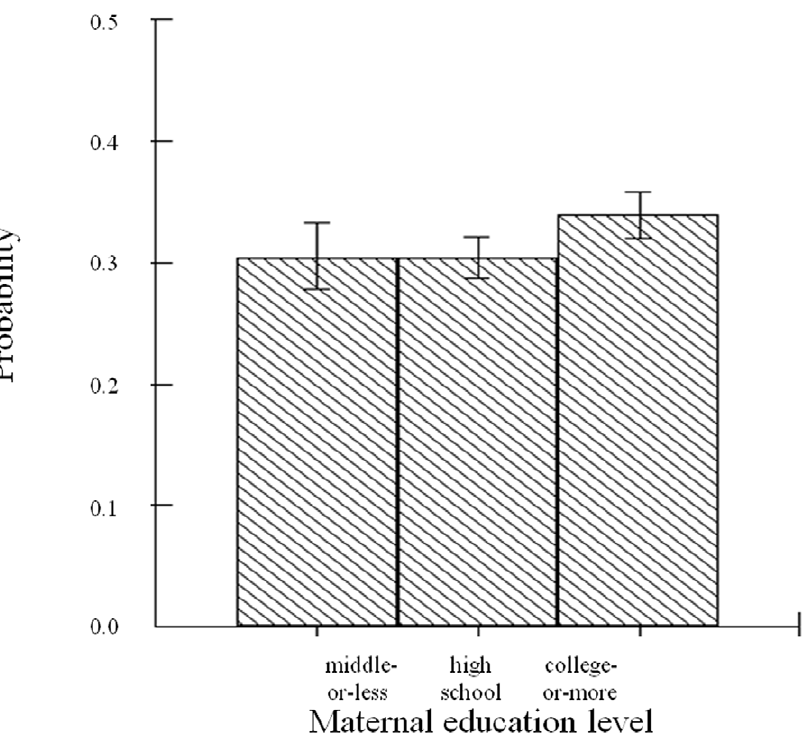
Figure 1. Probability of depression experience across maternal education level in male students.